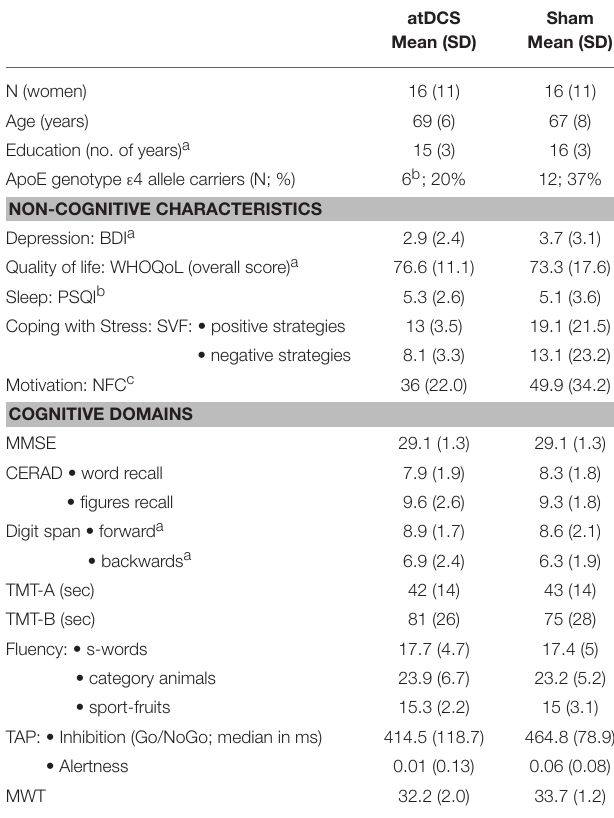
TABLE 1 | Demographic, non-cognitive, and cognitive baseline characteristics for healthy older adults grouped according to stimulation (atDCS, sham) applied in the 1st study